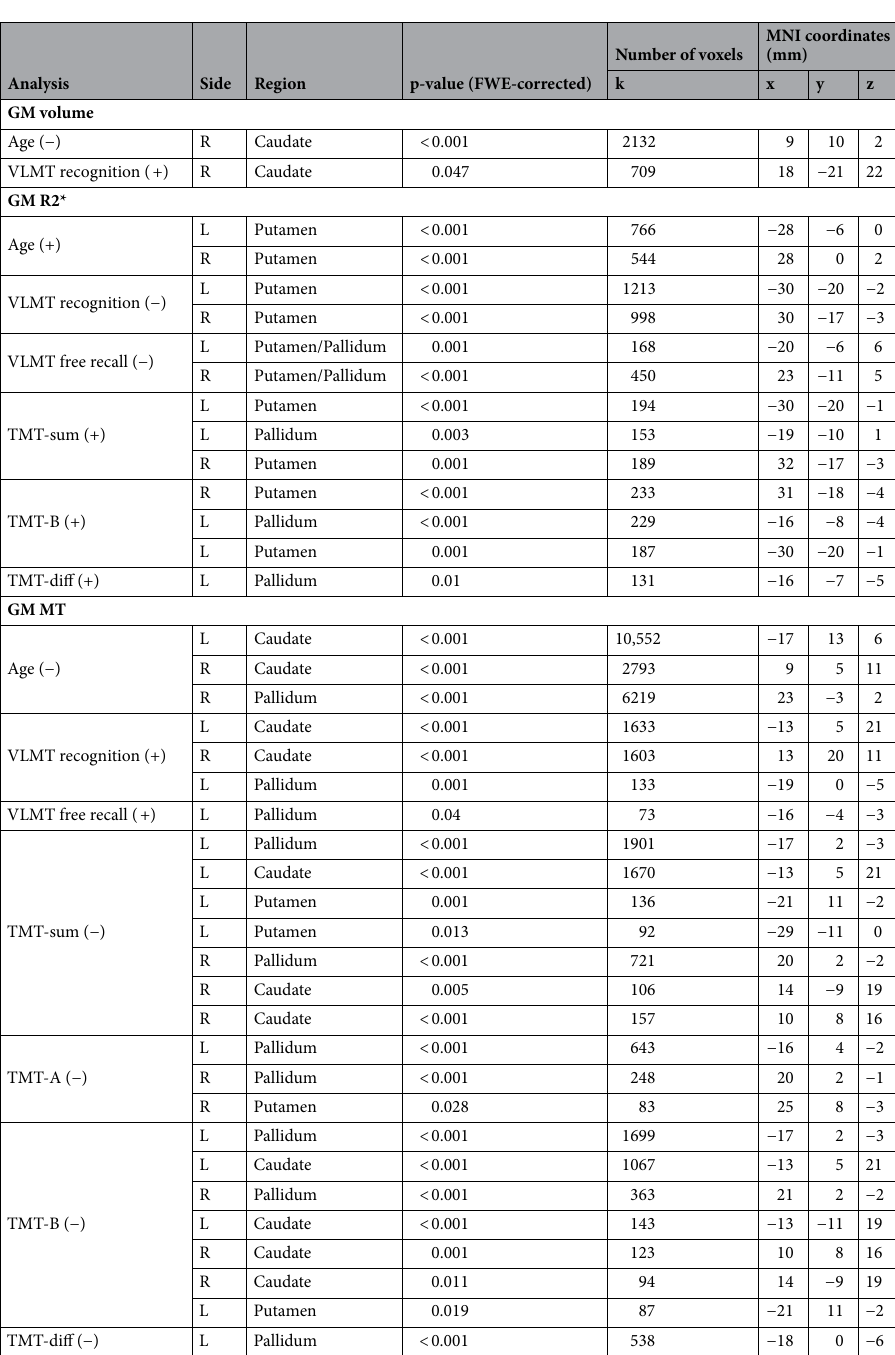
Table 1. Results of VBM and VBQ. Table shows results of VBM and VBQ (on R2* and MT GM) multiple regressions. Positive effects (one sided) are marked with a (+) and negative effects with a (−). P-values correspond to the cluster (FWE corrected) and the MNI coordinates to the respective peak voxel. Note that for VLMT recognition and the TMT separate regression analyses were performed (see